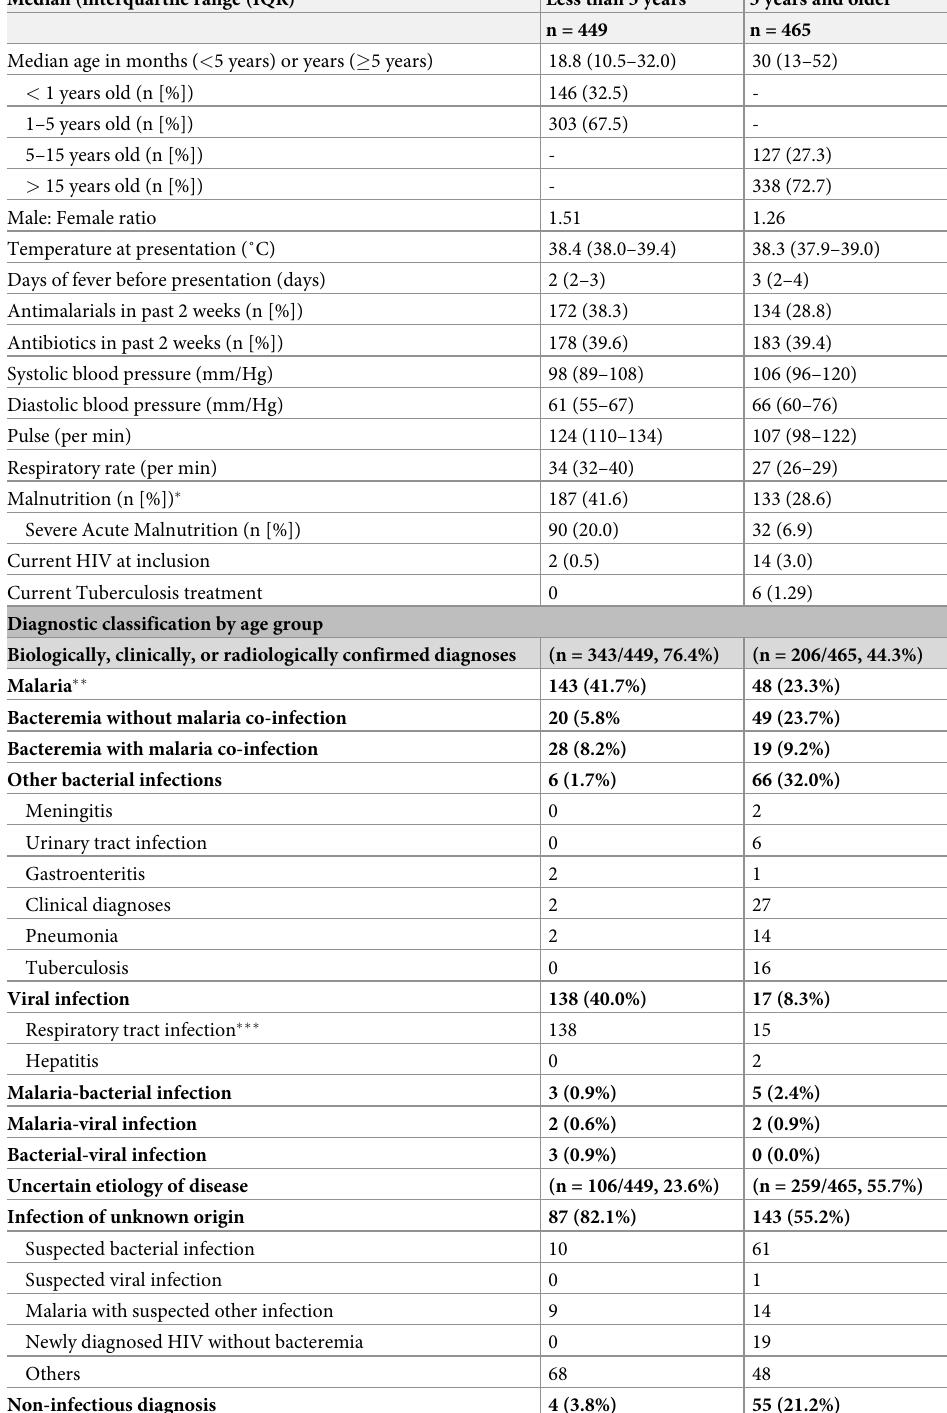
Table 1. Baseline characteristics and diagnostic classification by age group (n =